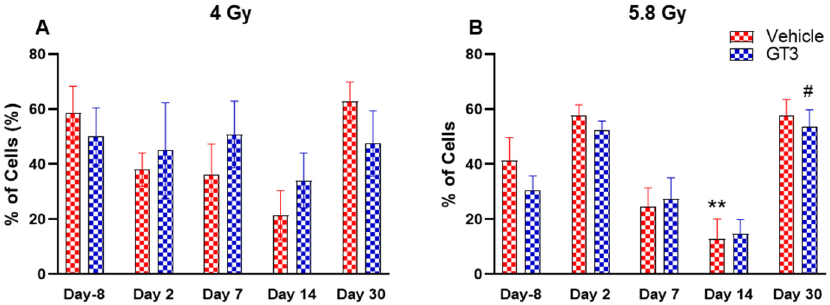
Figure 10. Effects of 4 Gy ( A ) and 5.8 Gy ( B ) on granulocyte and monocyte expression in BM of NHPs. NHPs received GT3 (37.5 mg/kg) or vehicle 24 h prior to irradiation (4 and 5.8 Gy). BM was collected at various time points and the expression of granulocytes and monocytes were analyzed. Data are expressed as mean ± SEM. ** p < 0.01 vs. vehicle day-8; # p < 0.05 vs. GT3 day-8.